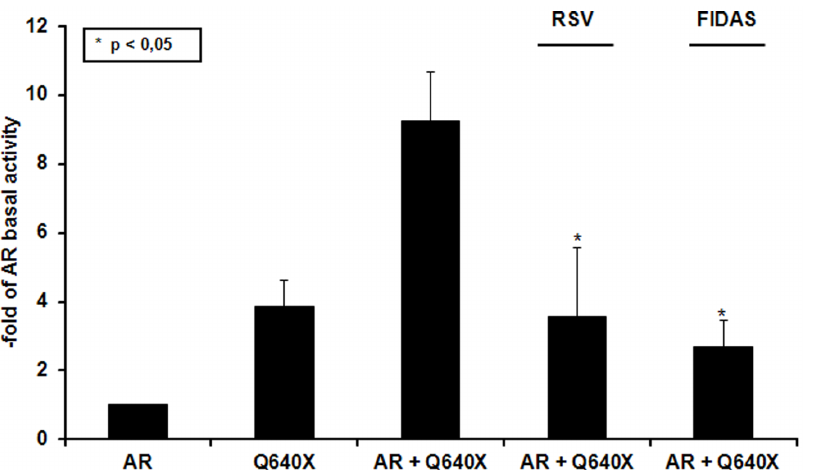
Figure 3. Effects of RSV and FIDAS on AR/Q640X-signalling under androgen deprived conditions. PC-3 cells were transiently transfected with AR, Q640X or AR + Q640X, together with pPSA-61luc and pRL-TK reporter plasmids as described in Material and Methods. Cells expressing Q640X and/or AR were grown for 24 hours in presence/absence of RSV (100 m M) or FIDAS (50 m M). Data are expressed in fold AR basal activity which was set to 1. As depicted, RSV and FIDAS significantly decreased PSA-promoter mediated reporter gene activity in Q640X and AR co-expressing cells, *p . 0.05.